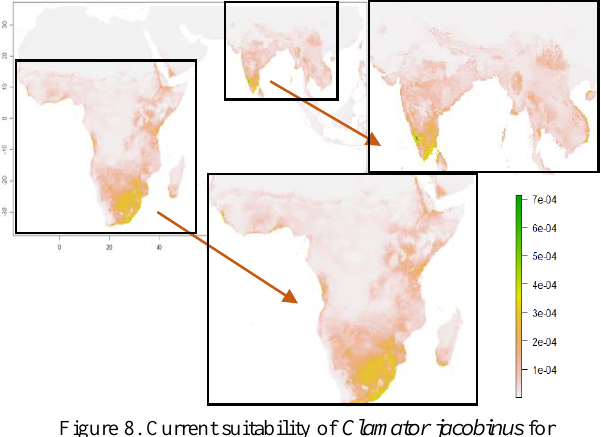
Figure 8. Current suitability of Clamator jacobinus for